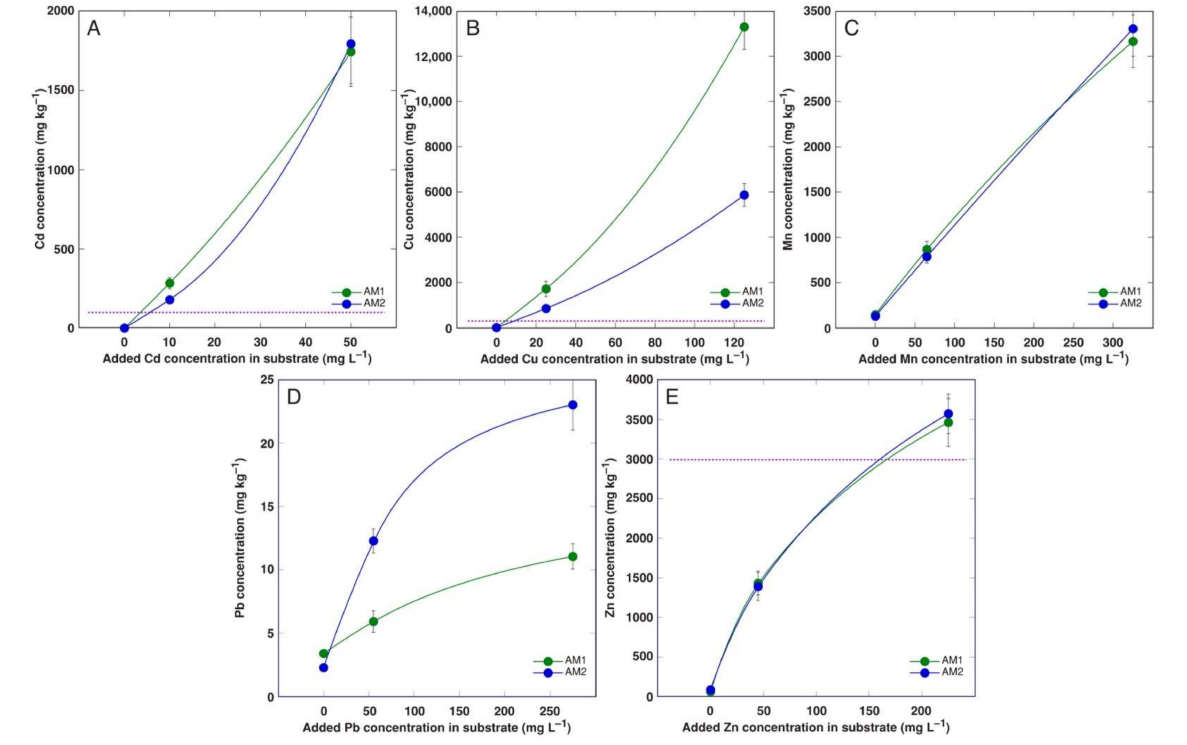
Figure 2. Concentration of heavy metals in plantlet tissues of Armeria maritima accessions AM1 and AM2 treated with heavy metals after 4 weeks in tissue culture: ( A ), cadmium; ( B ), copper; ( C ), manganese; ( D ), lead; ( E ), zinc. Data are means ± SE from 3 samples. Dotted line indicates accepted hyperaccumulation threshold level for the respective